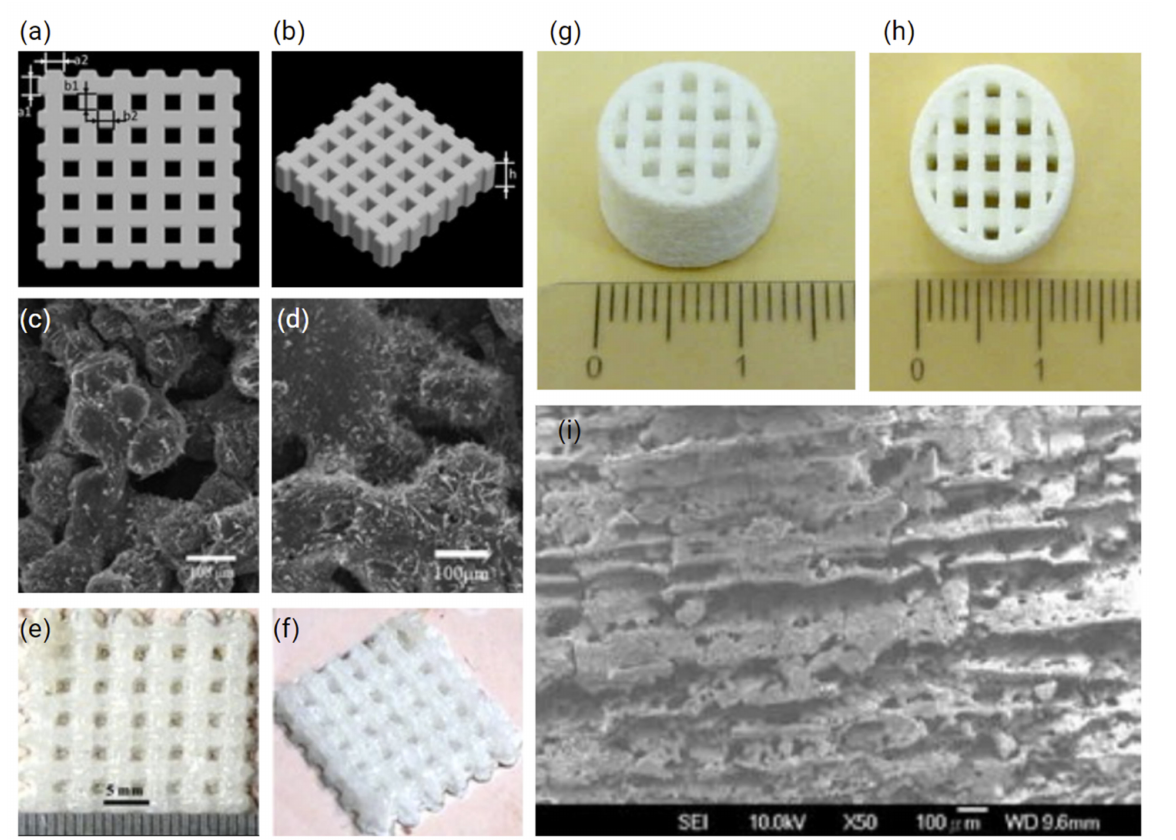
Figure 8. ( a , b ) CAD of crosshatch scaffolds using SolidWorks ® (version 2011, Dassault Syst è mes Solid- Works Corporation, Waltham, MA, USA). ( c , d ) Scanning electron micrographs and ( e , f ) overviews of SLS 45S5 Bioglass scaffolds fabricated via SLS. Adapted from [172] ( g – i ) HA-nanosilica sol composite scaffolds. Adapted from